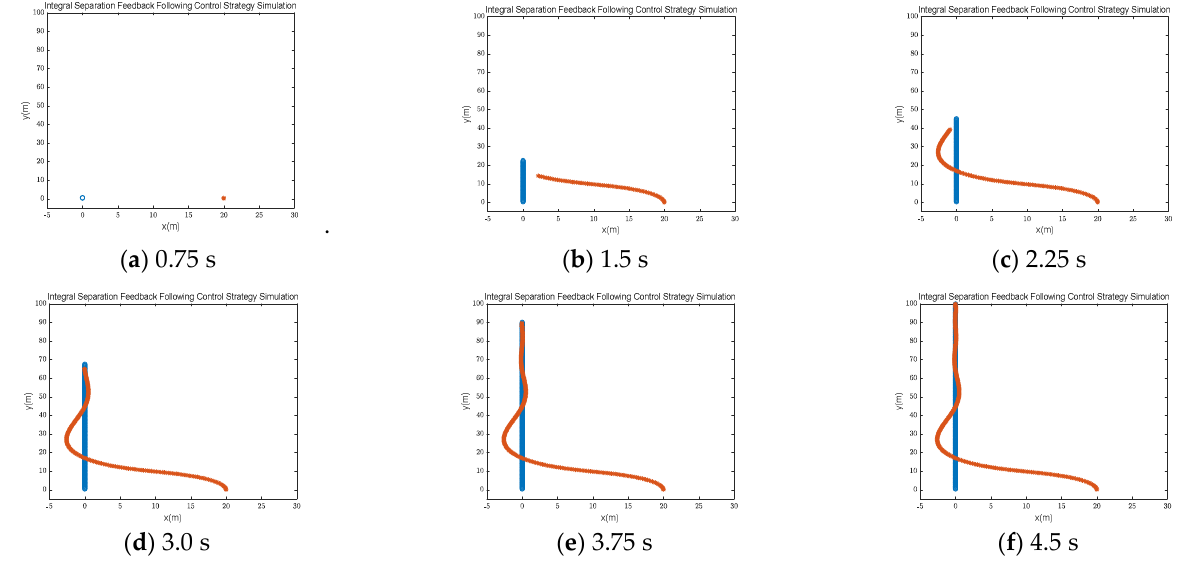
Figure 5. Integral separation feedback following control simulation results ( K p = 2 ( k 2 = 2), recorded every 0.75 s). The blue line is the trajectory of the leading vehicle and the red line is the trajectory of the following vehicle.